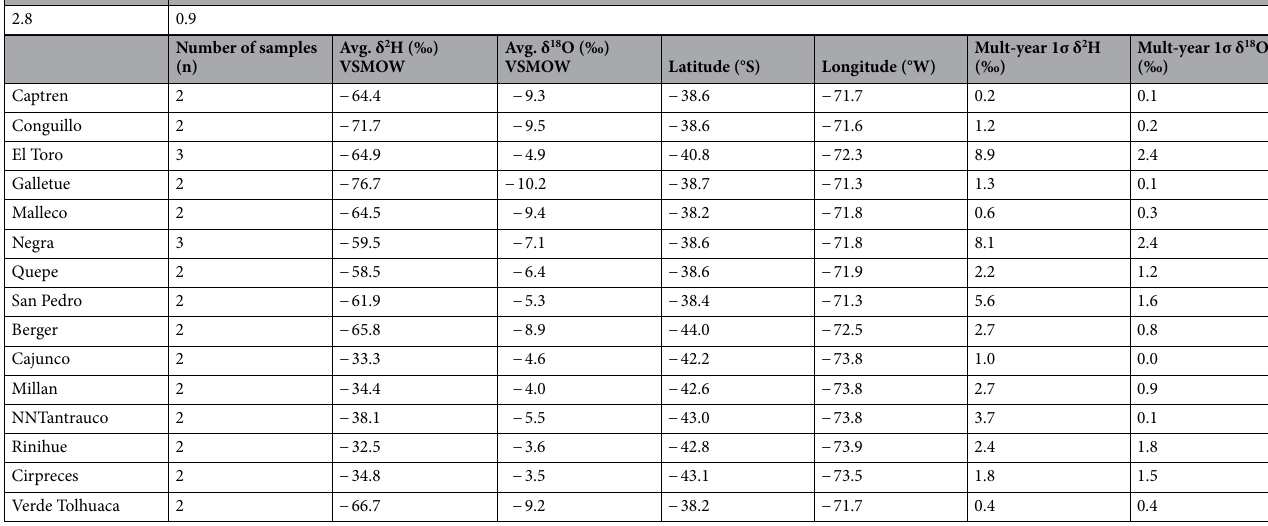
Table S1. Lakes with 2+ sampling